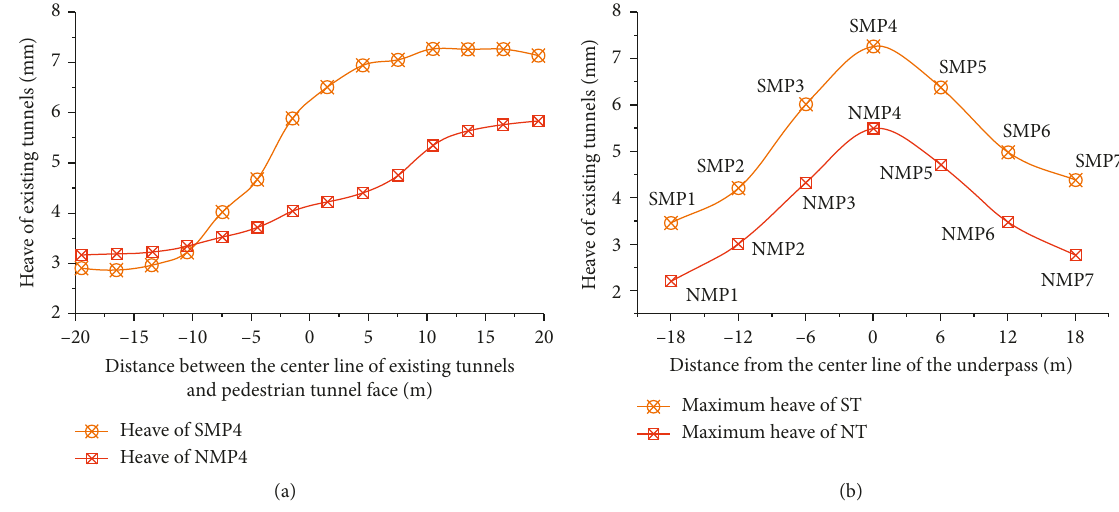
Figure 13: Heave of existing tunnels: (a) heave of the tunnels; (b) heave of monitoring